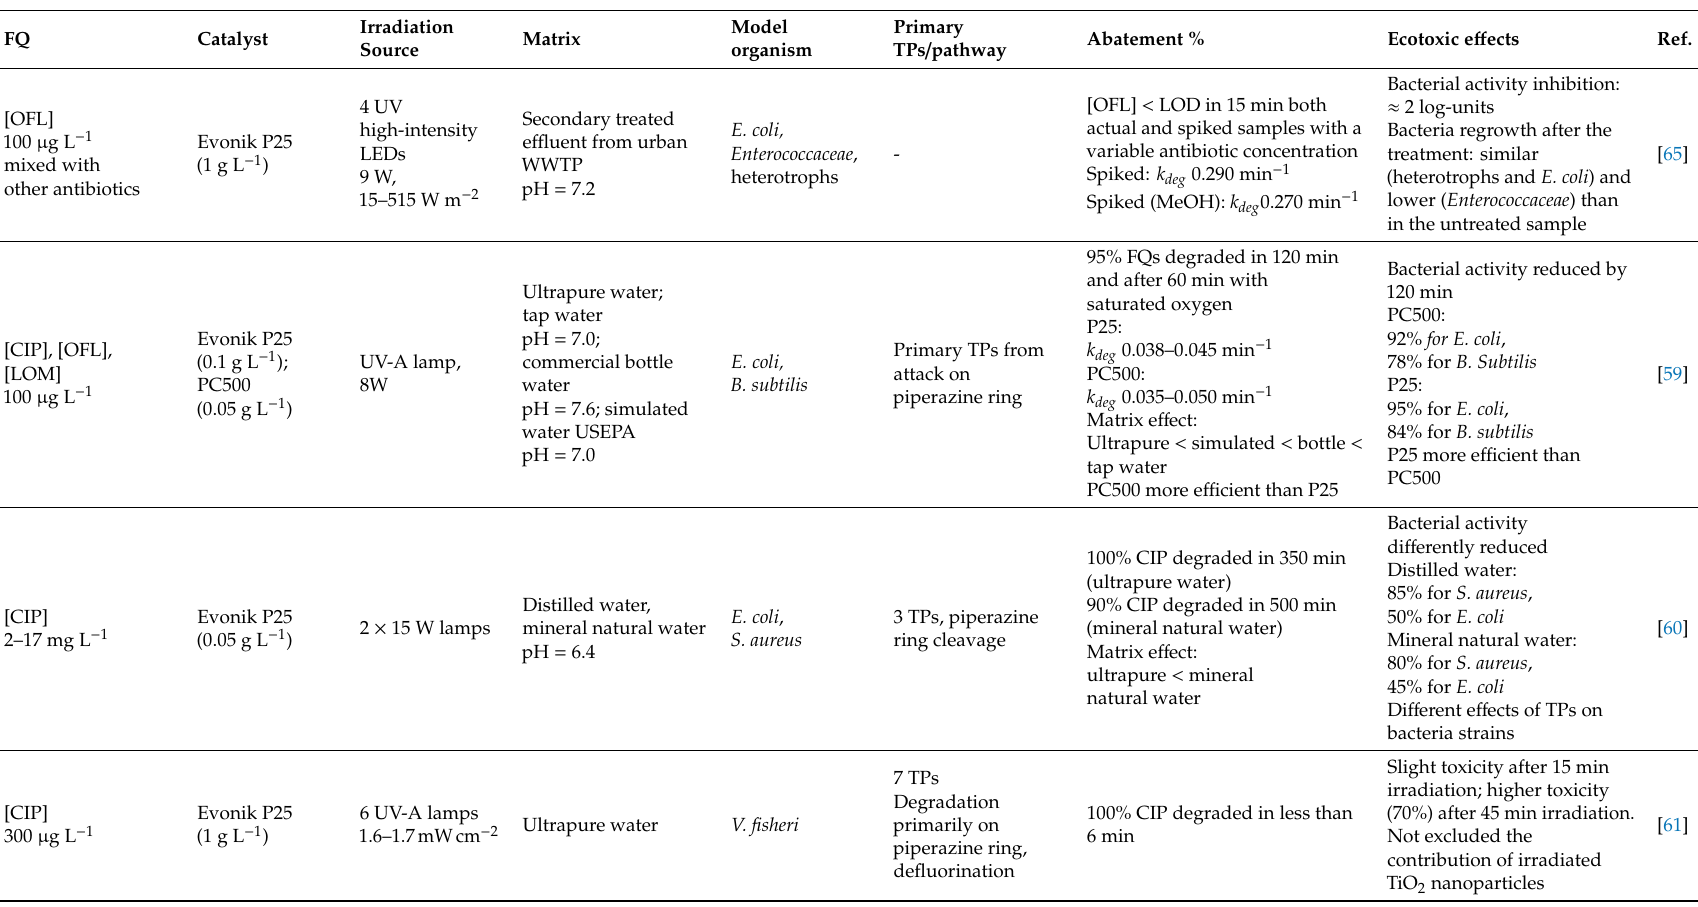
Table 1. Exemplificative conditions of the photocatalytic degradation of fluoroquinolones and antibacterial and eco-toxicological